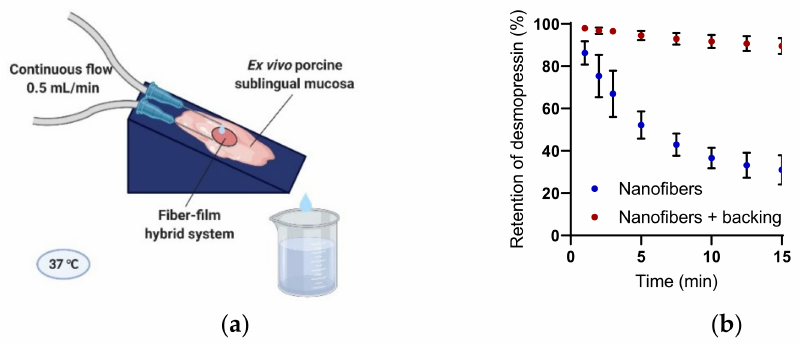
Figure 3. Nanofiber–film hybrid system protects desmopressin from wash-out by saliva. ( a ) Ex vivo porcine sublingual mucosa was mounted on a support with an angle of 16 ◦ and the retention of desmopressin on the tissue was evaluated over time. Created by Biorender.com. ( b ) Retention of desmopressin dosed in nanofibers with and without a saliva-repelling backing film on ex vivo porcine sublingual mucosa. N = 4, where N specifies the number of biological